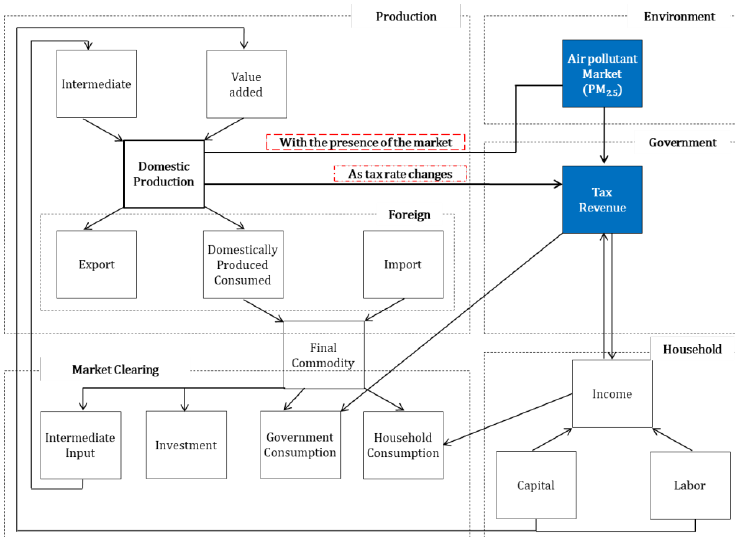
Figure 6. Structure and interwoven relationships among the agencies of the regional computable general equilibrium model (note: blue squares are two policy schemes used in the model and arrows indicate the flow of economic activities).